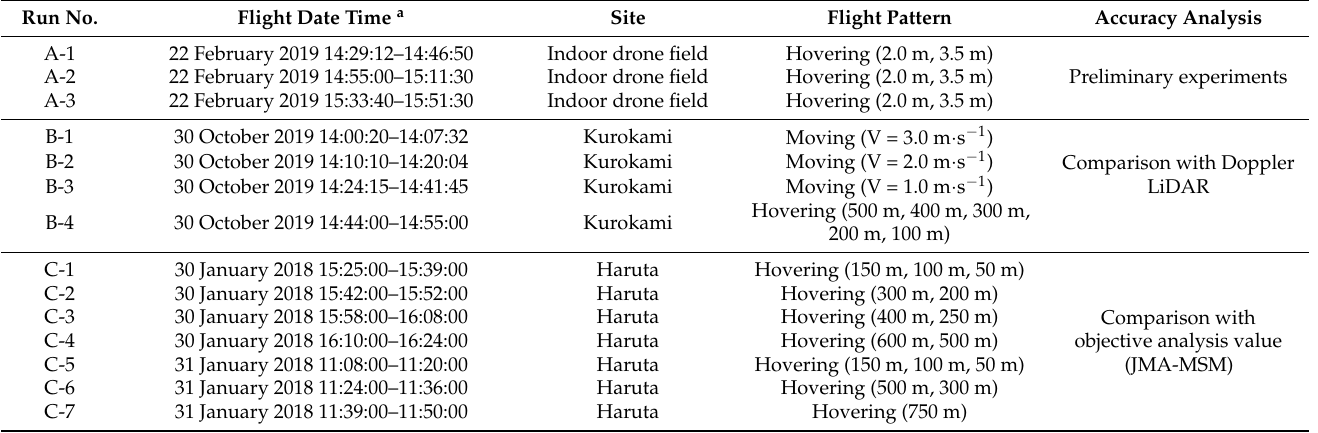
Table 1. Overview of drone flight for preliminary analysis and field observations.